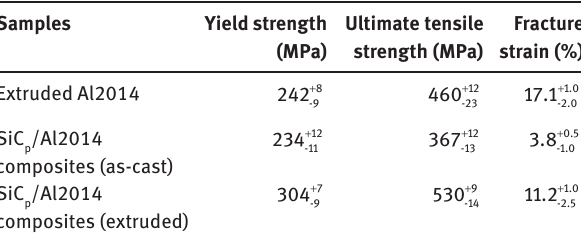
Figure 7: Tensile engineering stress-strain curves of the extruded Al2014 and SiC /Al2014 composites before and after extrusion. p Table 2: Yield strength, ultimate tensile strength, and fracture strain of the extruded Al2014 and 4 vol.% SiC /Al2014 composites p before and after